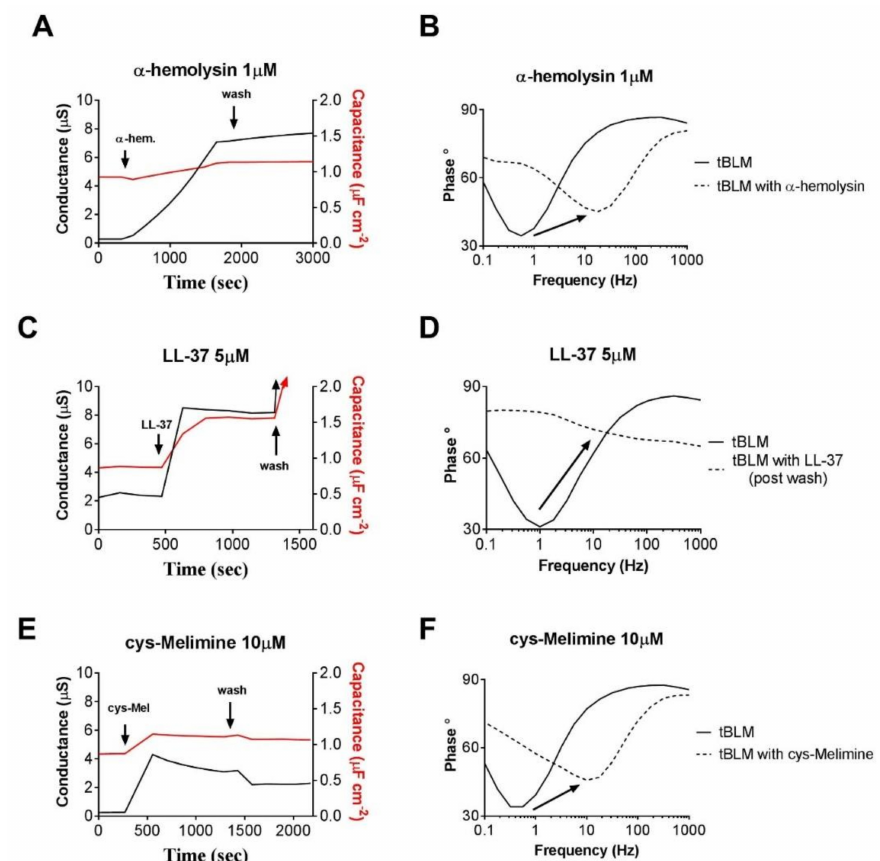
Figure 6. The tethered bilayer lipid membrane (tBLM) responses presented here are actual data obtained in the laboratory of the authors. ( A ) Membrane conduction and capacitance responses to the membrane ion channel forming antibiotic α -hemolysin. ( B ) Phase versus frequency (Bode Plot) before and after addition of the antibiotic α -hemolysin. The phase minima typically shift to higher frequencies with little increase in the phase angle. ( C ) Membrane conduction and capacitance responses to the human defensin peptide, LL-37, that causes membrane lysis. The responses are particularly evident after the membrane undergoes a wash step which induces mild sheer stress at the membrane. ( D ) Phase versus frequency (Bode Plot) response of LL-37. The phase minima typically shift to higher frequencies with very large increase in the phase angle. This phase signature is evidence of the tBLM undergoing irrevocable disruption. ( E ) Membrane conduction and capacitance responses to the AMP cys-Melimine [37]. A mild increase in membrane conduction is evident at relatively high concentrations of the AMP with a small change in membrane capacitance. The responses are partially reversed after washing. Note that the concentration of the AMP is 10 times larger than that for the ion channel α -hemolysin (Figure 6A). ( F ) Phase versus frequency (Bode Plot) response of the AMP cys-Melimine. The phase minima typically shift to higher frequencies with only a small increase in the phase